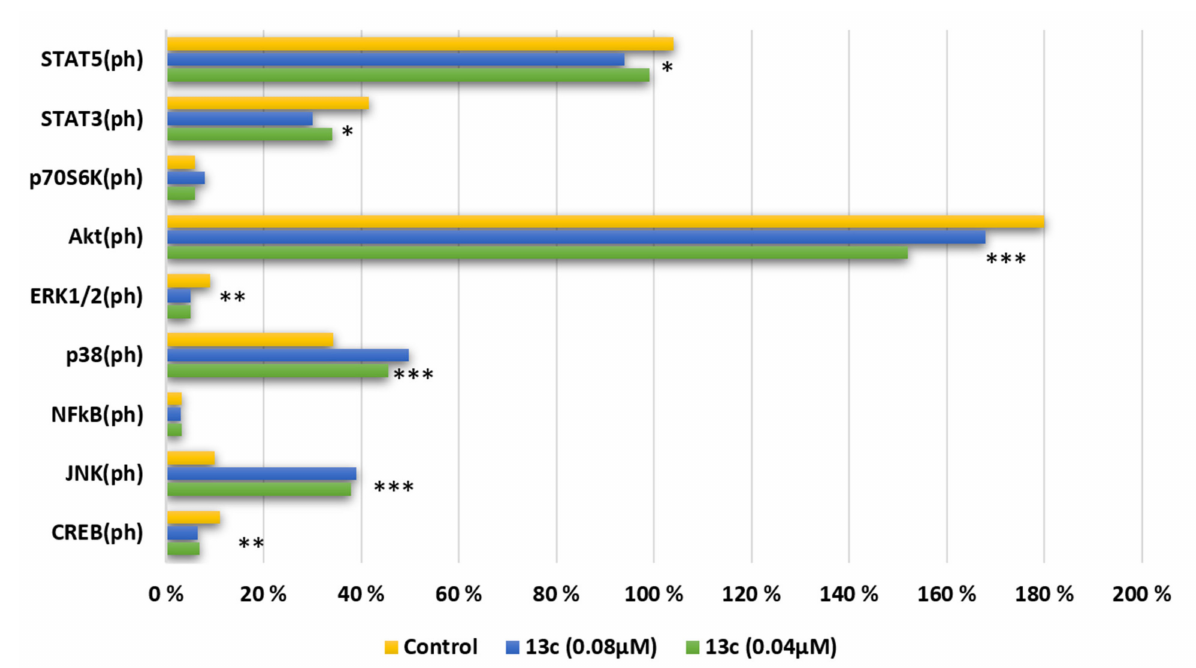
Figure 9. Effect of compound 13c on intracellular signaling (CREB, JNK, NFkB, p38, ERK1/2, Akt, p70S6K, STAT3) through the activation of tyrosine kinases of the main pathways of cell proliferation and differentiation. Phosphorylation levels of key members of the 9 most important signaling pathways were determined using the MILLIPLEX ® MAP 9-Plex Multi-Pathway 9-plex Magnetic Bead Kit (Luminex) in protein harvested from control cells and cells treated with the substance after 24 h of incubation (Jurkat cells were used). Phosphorylation levels in control HeLa cells were taken as 100%. Phosphorylation levels were adjusted for protein load by the levels of total protein (non-phosphorylated) determined using the 9-Plex Multi-Pathway Total Magnetic Bead Kit (Luminex) in the same sample. Data are presented as mean plus standard error (* p > 0.05, ** p > 0.01, *** p >